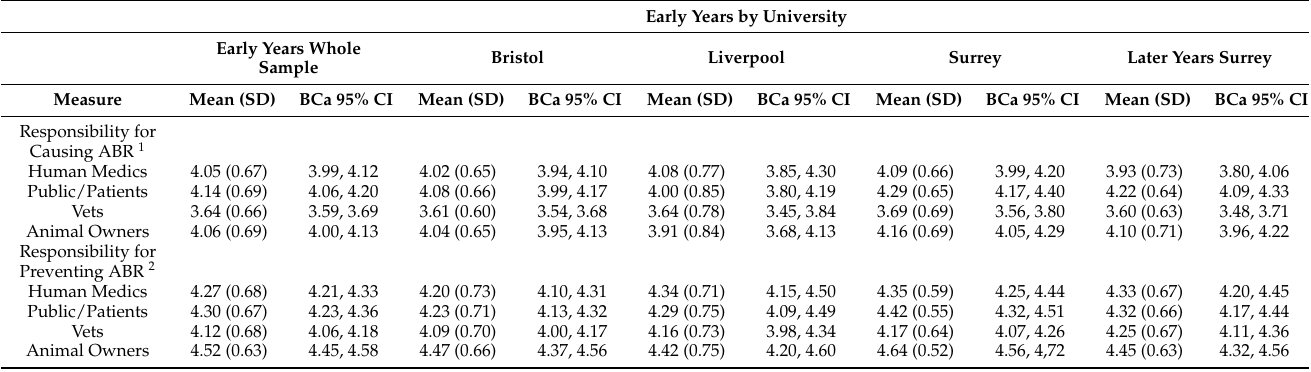
Table 6. Mean beliefs about groups’ responsibility for causing and preventing ABR.